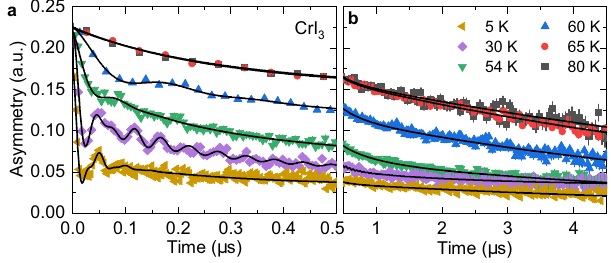
Fig. 1 μ SR spectroscopy applied to CrI 3 . a , b Zero- fi eld μ SR spectra recorded at various temperatures for the polycrystalline sample of CrI 3 shown in the low and extended time interval. The solid lines are the fi t of the data using the methods of Supplementary Note 2. Error bars are the standard error of the mean in about ~ 10 6 events. The error of each bin count is given by the standard deviation of n . The errors of each bin in the μ SR asymmetry are then calculated by statistical error propagation.